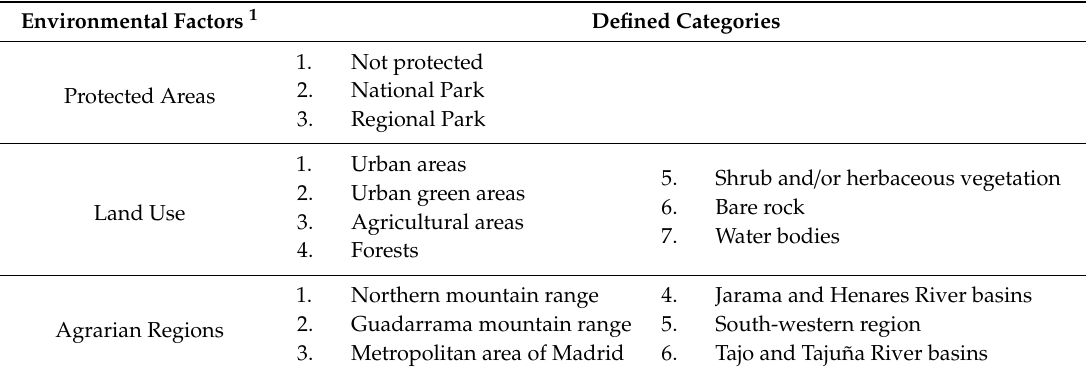
Figure 2. Socio-economic profile of participants. Table 2. Layers generated to achieve each of the research objectives. The name of the layers is shown, along with the categories that were generated in each one of them for the statistical